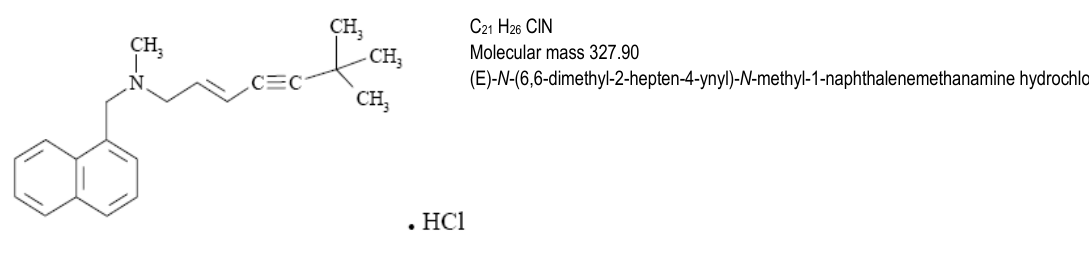
Figure 1: The molecular structure of terbinafine